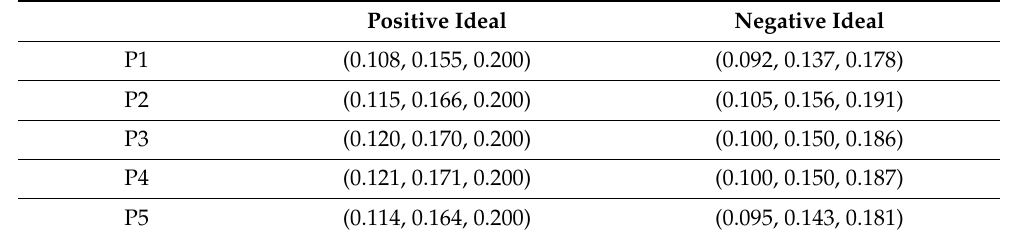
Table 7. The positive and negative ideal